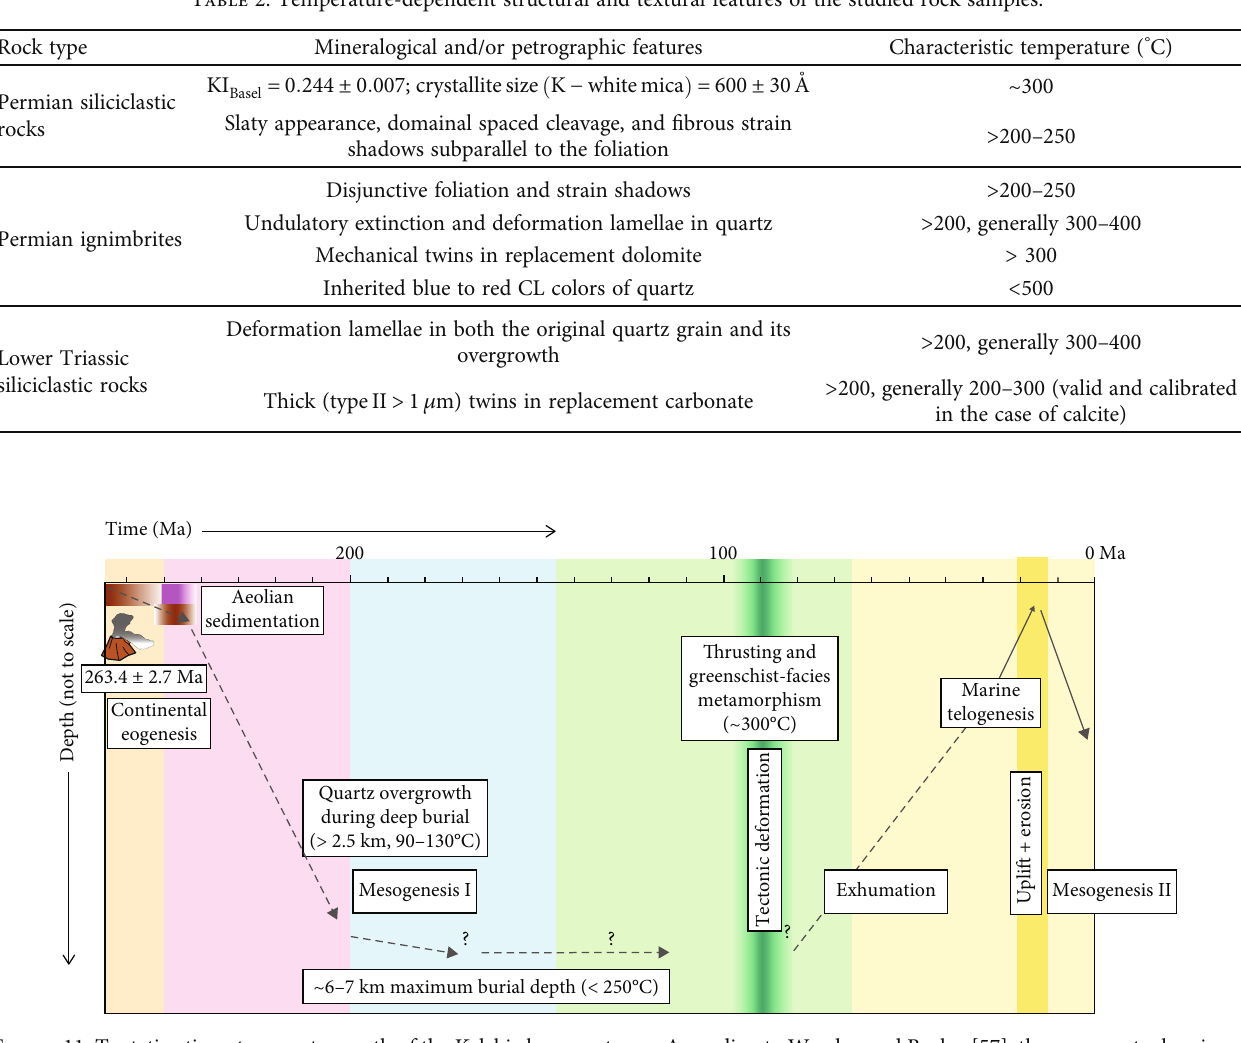
Figure 11: Tentative time – temperature path of the Kelebia basement area. According to Worden and Burley [57], three conceptual regimes of diagenesis are indicated: (i) eogenesis (early diagenesis), (ii) mesogenesis (burial diagenesis), and (iii) telogenesis (uplift-related